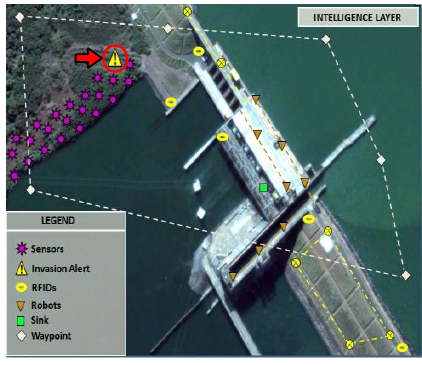
Figure 2. Layered Interface: Intelligence Layer.